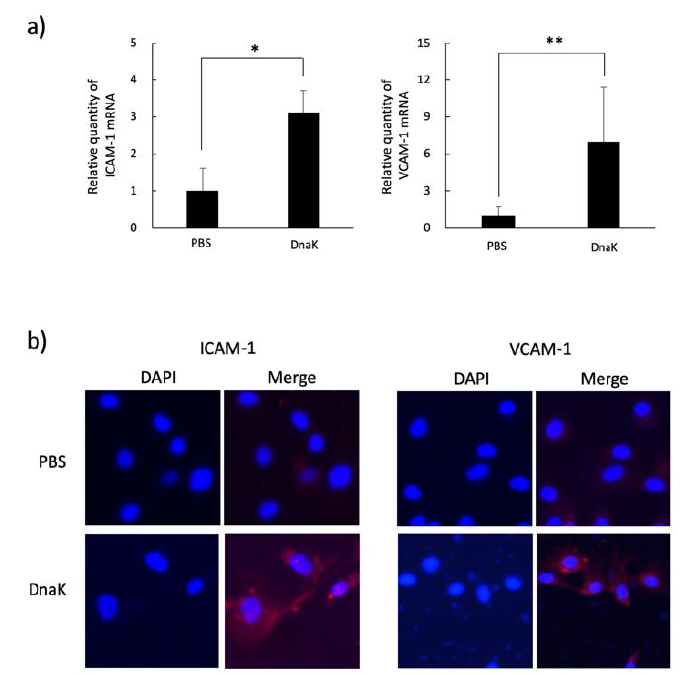
Figure 5. Induction of adhesion molecules in HUVECs stimulated with A. defectiva rDnaK. The expression of adhesion molecules on HUVECs stimulated with A. defectiva rDnaK was performed by the quantitative real-time RT-PCR method using the primer ICAM-1 VCAM-1 ( a ). The expression of the adhesion molecules was analyzed with an immune-staining assay using monoclonal anti-ICAM-1 antibodies (dilution; 1:200) or anti-VCAM-1 antibodies (dilution; 1:200), followed by treatment with an Alexa Fluor 594-conjugated goat anti-rabbit IgG, and the nuclei were stained with DAPI ( b ). Data are expressed as the mean ± SD from three independent experiments, each performed in duplicates. Six samples were analyzed in each group. Statistically significant differences; NS, not significant, * p < 0.05, ** p < 0.01